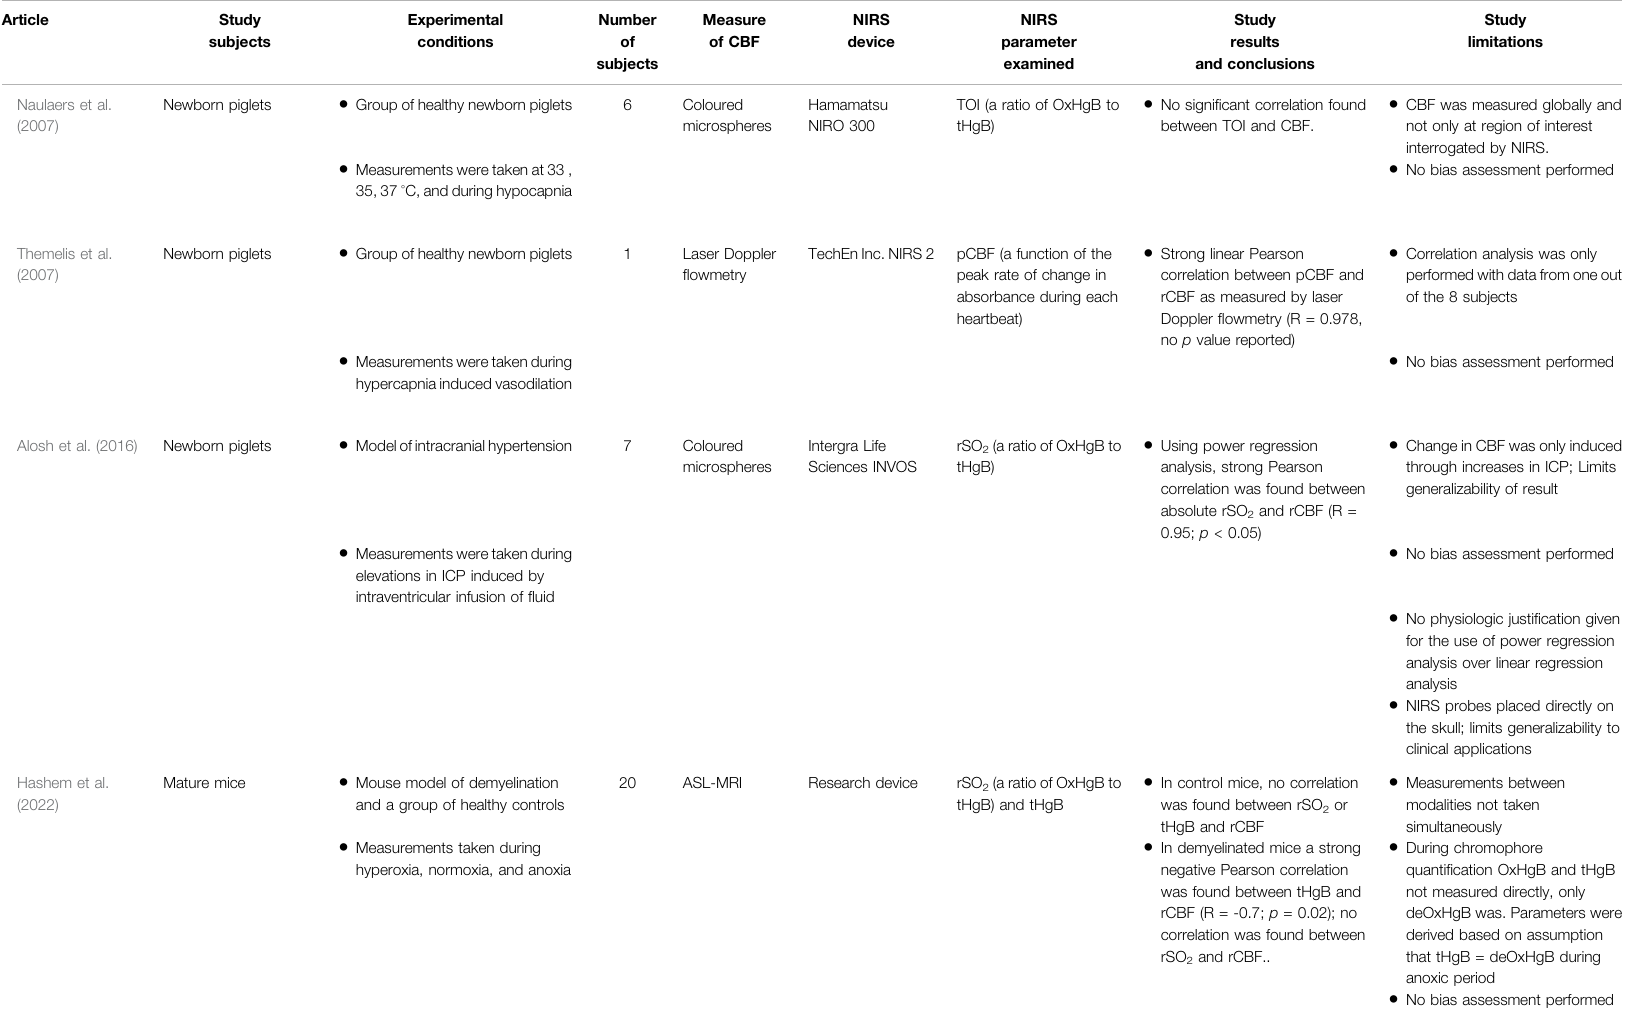
analysis over linear regression